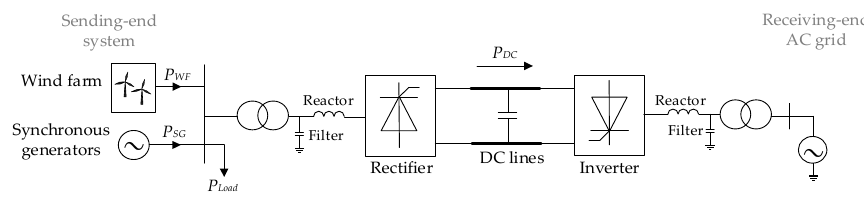
Figure 1. Configuration of HVDC asynchronous interconnected grid with WF.